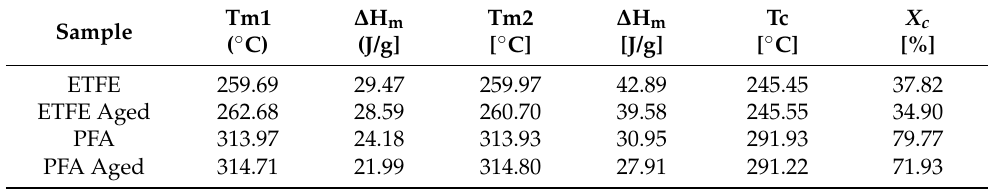
Table 8. Melting temperature, melting enthalpy, and the crystallinity of non-aged and aged